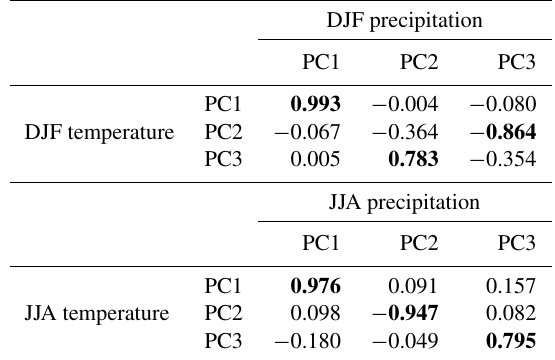
Table 5. R correlation values for PC scores for temperature and precipitation in DJF and JJA. Values where R 2 ≥ 0.5 are shown in